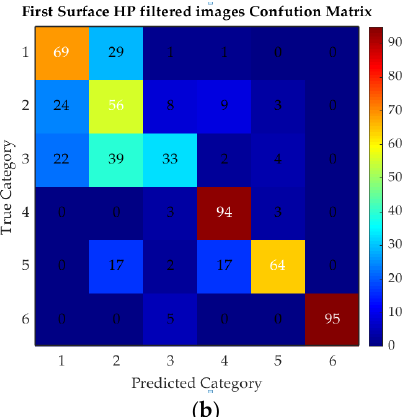
Figure 27. The impact of scale of analysis on the performances of a compressed-domain classifier: ( a ) the relation between the scale of analysis and the six surface categories’ compression and classification performances by using the multiscale BP data sets and ( b ) a confusion matrix for six surface categories classification by using 50% of the highest-scale BP data set for training.